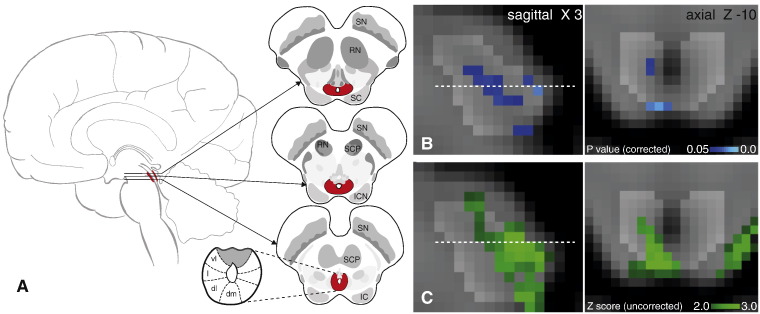
Periaqueductal grey (PAG) response to breath hold. A. Representation of the location of the PAG within the brain, three sagittal slices and the current opinion of the subdivisions of the PAG. B. Localisation of the functional decreases in BOLD signal within the PAG (p < 0.05; small-volume-corrected for multiple comparisons using overlaid PAG mask), where the images consist of a colour-rendered statistical map superimposed on a standard (MNI 1 mm3) brain. Dashed line represents Z-10 location. C. Uncorrected Z score image of PAG deactivation from whole brain analysis, prior to masking. Abbreviations: SN, substantia nigra; RN, red nucleus; SC, superior colliculus; SCP, superior cerebellar peduncle; ICN, inter-colliculi nucleus; IC, inferior colliculus; vl, ventrolateral PAG, l, lateral PAG; dl, dorsolateral PAG; dm, dorsomedial PAG.